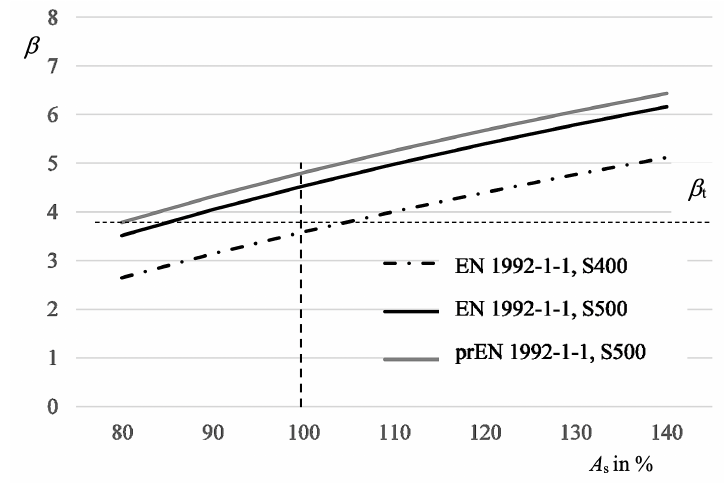
Figure 3. Variation of the reliability index β versus the percentage of required reinforcement area A of reinforcement (S400 and S500), considering EN 1992-1-1 and prEN 1992-1-1.